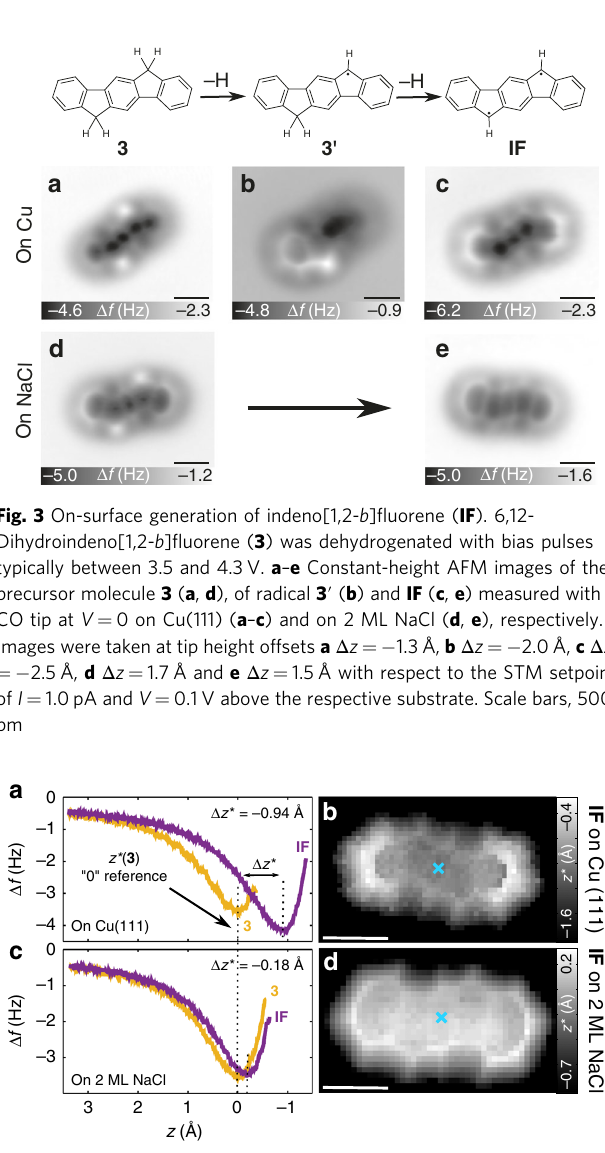
Fig. 4 Δ f ( z ) spectroscopy. a , c Δ f ( z ) curves taken over the central benzene ring of 3 (yellow) and IF (purple) adsorbed on a Cu(111) and c 2 ML NaCl. The z scale is offset by z *( 3 ) for the respective surface to show 3 at z = 0 as reference. b , d z * maps of IF adsorbed on b Cu(111) and d 2 ML NaCl. At z = − 1.6 Å on Cu(111) and z = − 0.7 Å on 2 ML NaCl (black regions), the approach was aborted to avoid tip instabilities, and z * was not reached above the bare surfaces. Scale bars, 500